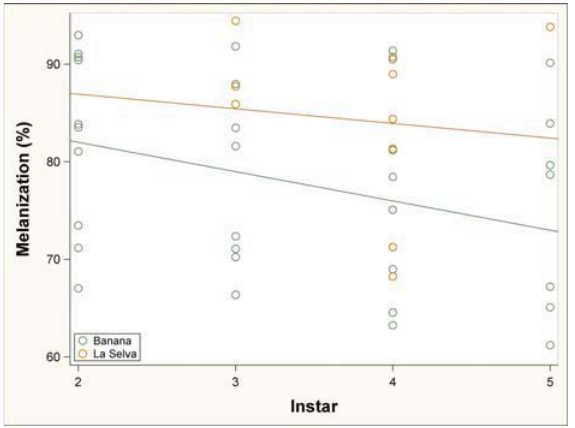
Figure 4. The percent melanization across four instars. Early instars had a slightly higher melanization score than later